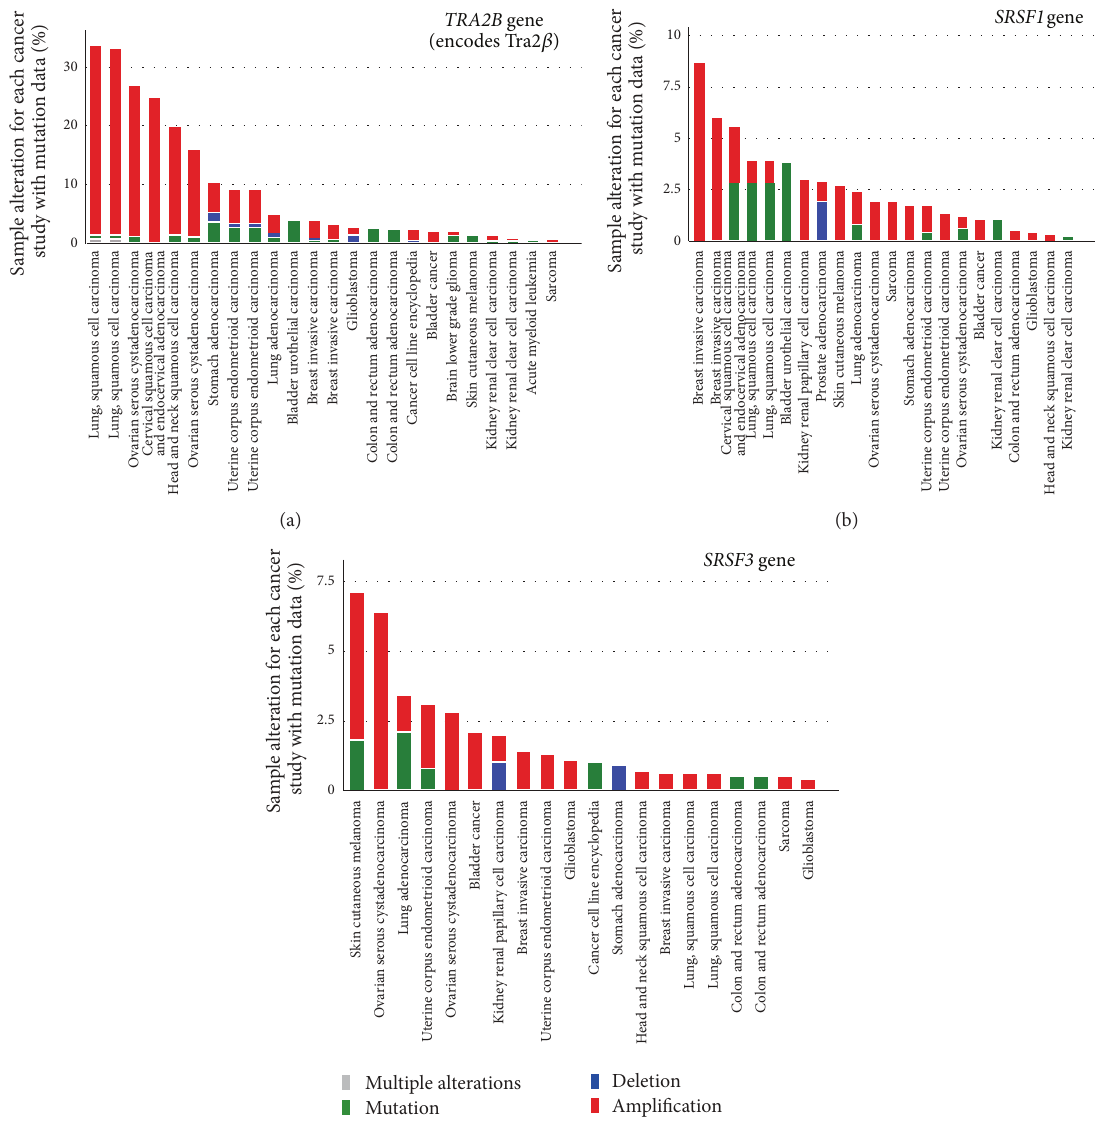
Figure 2: The (a) TRA2B , (b) SRSF1 (also known as ASF/SF2), and (c) SRSF3 (also known as SRP20) genes are amplified or otherwise mutated inseveralcancertypes.Foreachofthethreegenes,dataforgeneticchangesinallcancerswereobtainedusingthecBioPortaldatabase,filtering for percentage of altered cases (studies using mutation data) [22, 23]. The percentage, of cancer samples which showed genetic alterations in large cancer studies are shown on the Y axis and the respective type of cancer on the X axis. Full details of this kind of analysis are given on the cBioPortal website